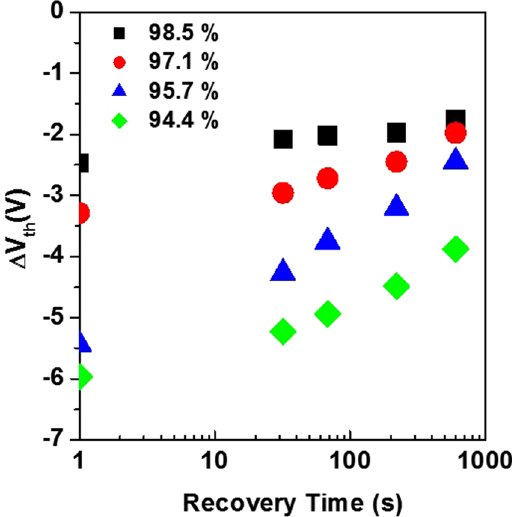
Figure 5. The change in Δ V th values after NBIS, as the devices are left to recover with the light turned off and without any voltage bias. Note that the devices based on ZnON grown with the highest oxygen content exhibit slowest recovery, which agrees well with the theoretical predictions that O-O peroxides will result in relatively slow recovery from the photo-excited state.